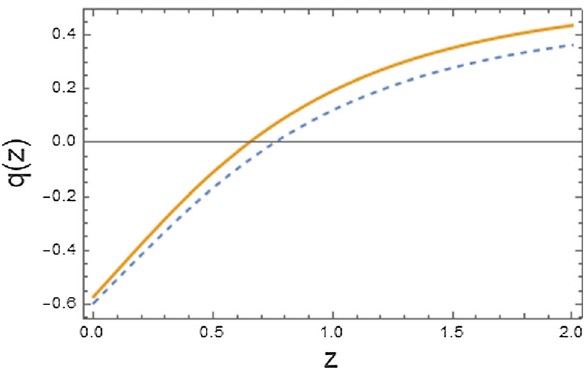
Fig. 4 Here we display the deceleration parameter for our asymmet- ric model (dashed line) together with that from the flat LCDM model (continuous